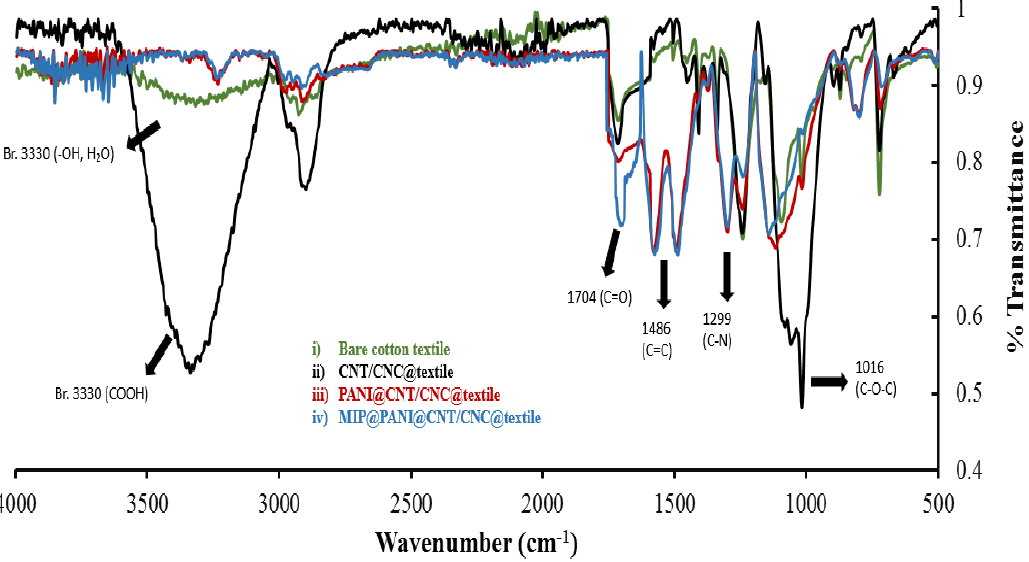
Figure 2. Overlapped FTIR spectra for (i) bare cotton textile; (ii) CNT/CNC@textile; (iii) PANI@CNT/CNC@textile; and (iv) MIP@PANI@CNT/CNC@textile